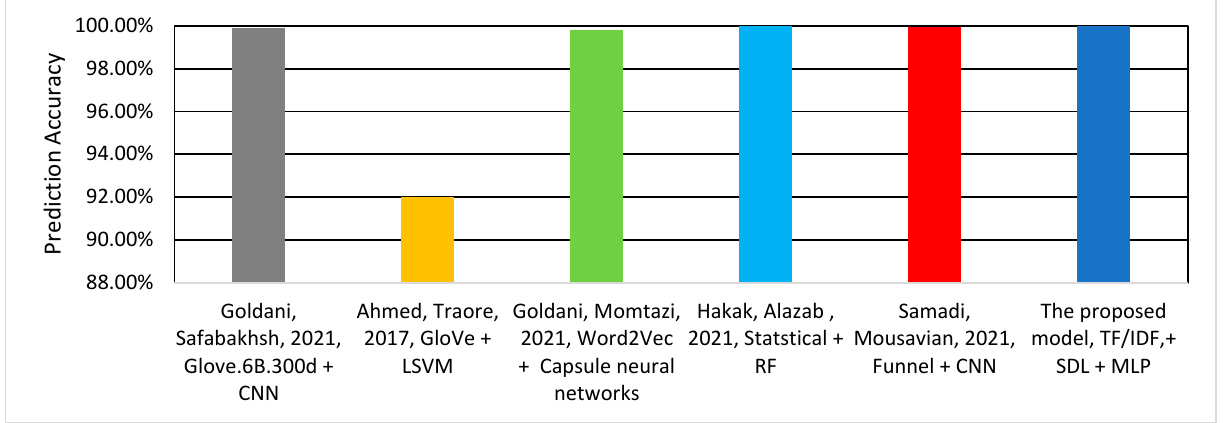
Figure 9. Classification Accuracy of the Models using ISOT Dataset.